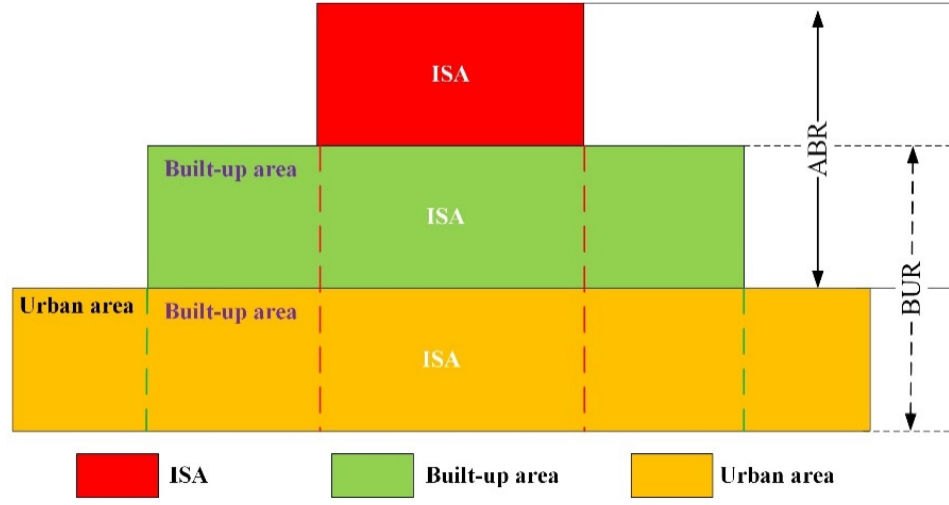
Figure 5. Structural framework of the UA–BUA–AISA.